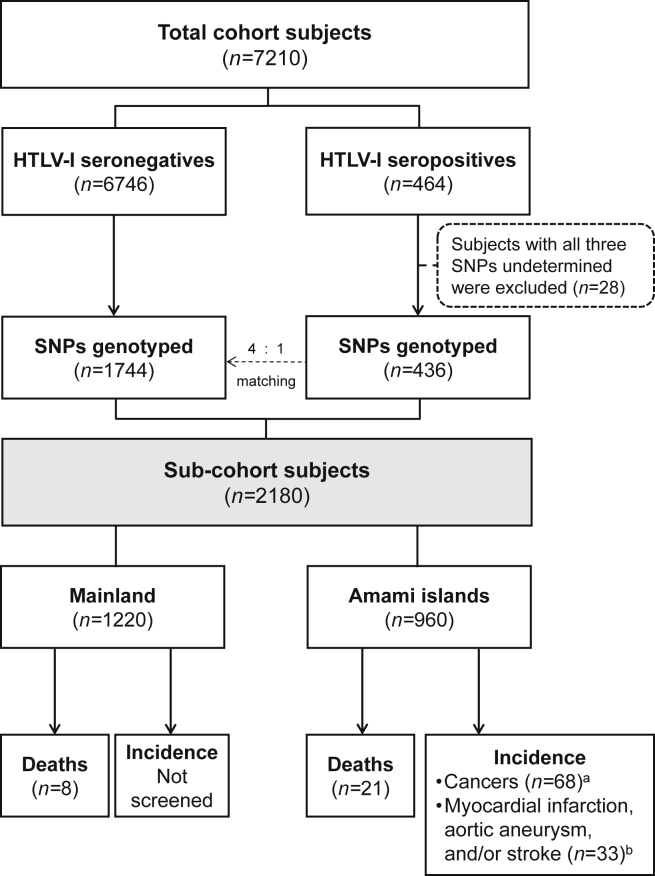
Flow-chart of the selection process of the sub-cohort subjects. aIncluded 5 death cases. bIncluded 1 death case.